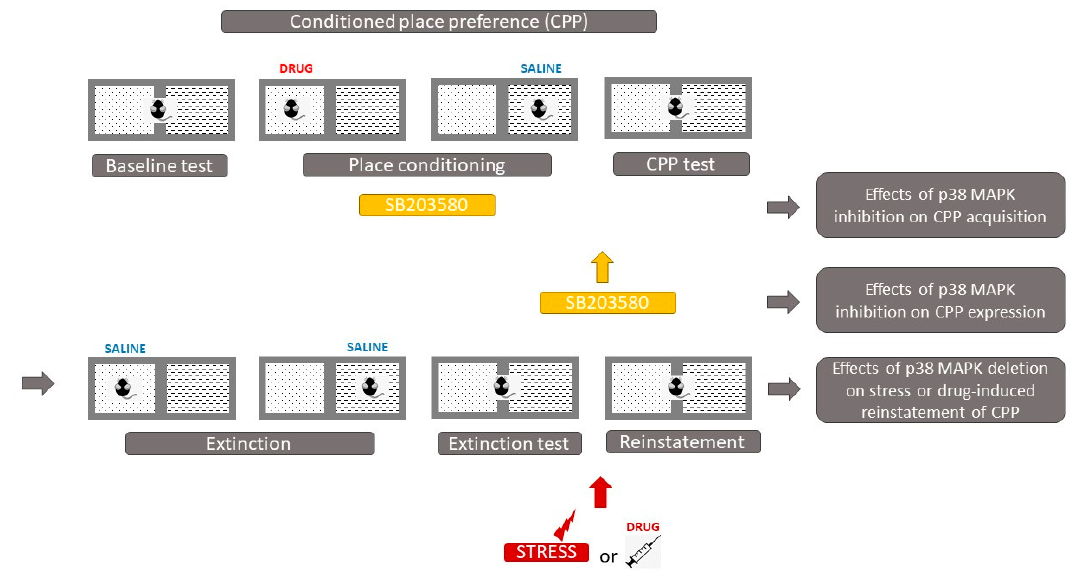
Figure 2. conditioned place preference (CPP). In the pre-conditioning day or baseline test, animals (such as mice) are allowed to freely explore the entire apparatus. The time that mice spend in each compartment is recorded to show the natural preference of animals. During conditioning, mice are randomly assigned to their drug and saline training compartments for the training sessions. Conditioned preference is assessed by allowing the mice to roam freely in all the compartments and recording the time spent in each. When the p38 MAPK inhibitor, SB203580, is injected before DRUG conditioning (the stimulus), the effects of p38 inhibition on CPP acquisition are investigated. Likewise, when SB203580 is injected before the CPP test, the effects of p38 inhibition on CPP expression are explored. After the CPP expression, mice can undergo extinction of CPP, during which they are conditioned repeatedly to saline in both compartments. By conditioning the animals with saline in their previous DRUG-associated compartment, mice progressively lose their preference to the compartment associated to the DRUG. When the animals reach the extinction criteria, which is checked by an extinction test, they can be tested for reinstatement of CPP. Reinstatement can be induced by an exposure to stress (stress-induced reinstatement of CPP) or also, by an exposure to a priming injection of the DRUG (drug-induced reinstatement). Place preference during reinstatement of CPP is again determined by allowing the mice to freely explore all the compartments of